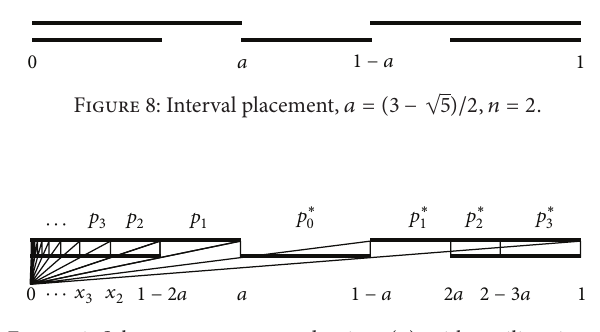
Figure 9: Scheme to construct a density 𝑝(𝑥) , with auxiliary inter- vals marked, 𝑎 = (3 − √5)/2 , 𝑛 = 2